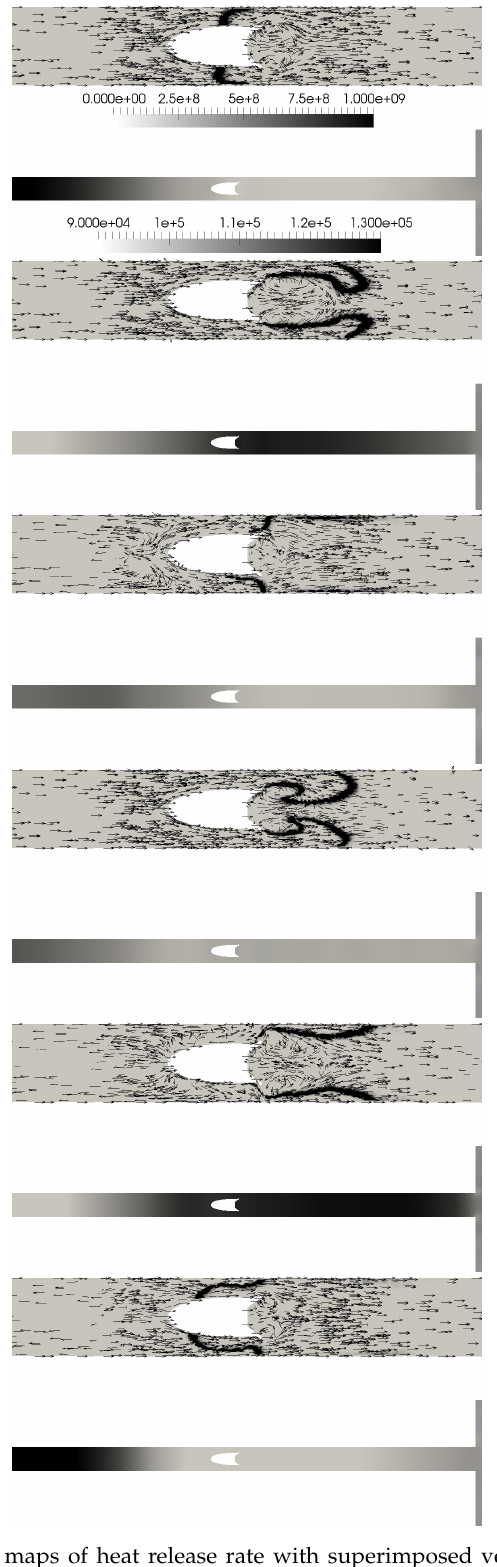
Figure 2. Instantaneous maps of heat release rate with superimposed velocity vectors ( top ) and pressure ( bottom ) at the times indicated with symbols in Figure